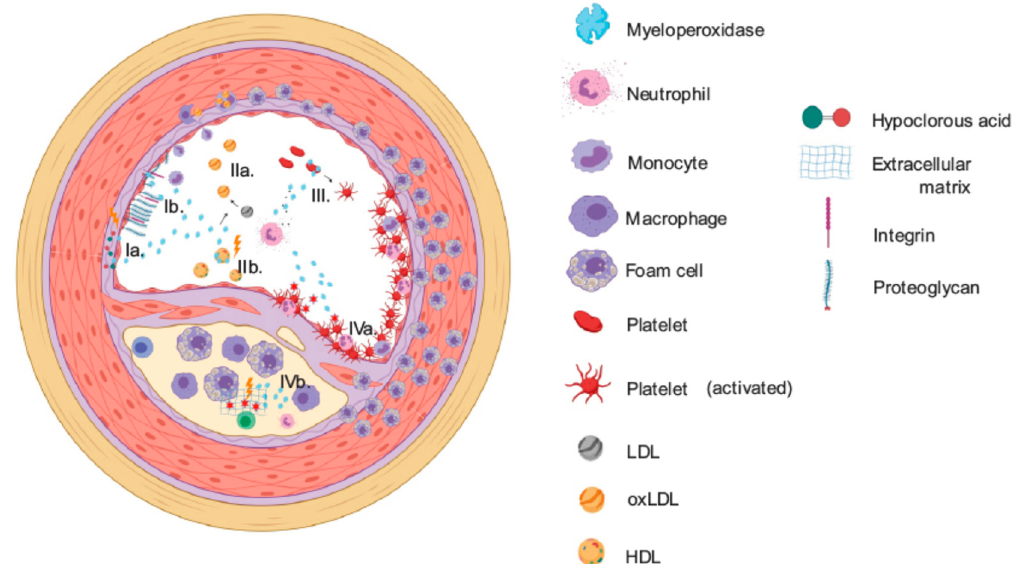
Figure 3. MPO as a mediator of vascular disease. MPO affects endothelial integrity and function by reducing NO bioavailability in the subendothelial space (Ia.) and collapsing the endothelial glycocalyx, compromising mechanosensitivity and exposing leukocyte receptors (Ib). The enzyme further oxidizes low-density lipoprotein (LDL) (IIa.) and modifies high- density lipoprotein (HDL) (IIb.) with respective atherogenic consequences. MPO-mediated platelet activation contributes to the formation of atheroma (III.). Within the plaque, active MPO is found to destabilize cell adhesion and extracellular matrix (IV.), which promotes plaque